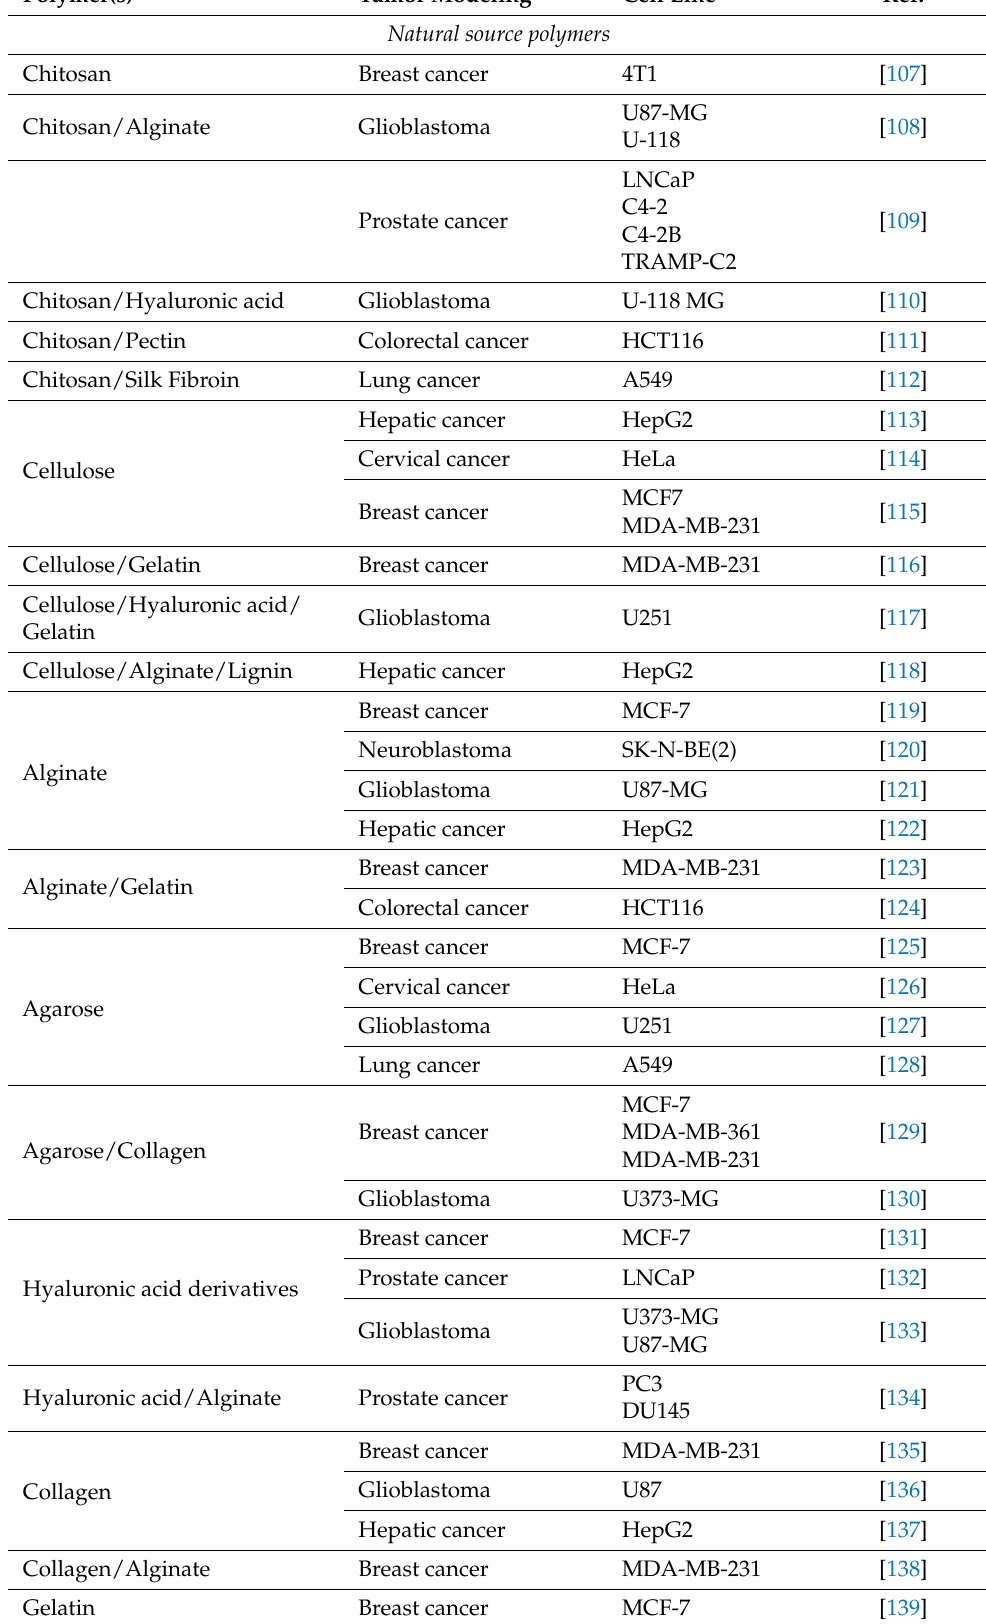
Table 3. Natural and synthetic polymers investigated for hydrogel tumor